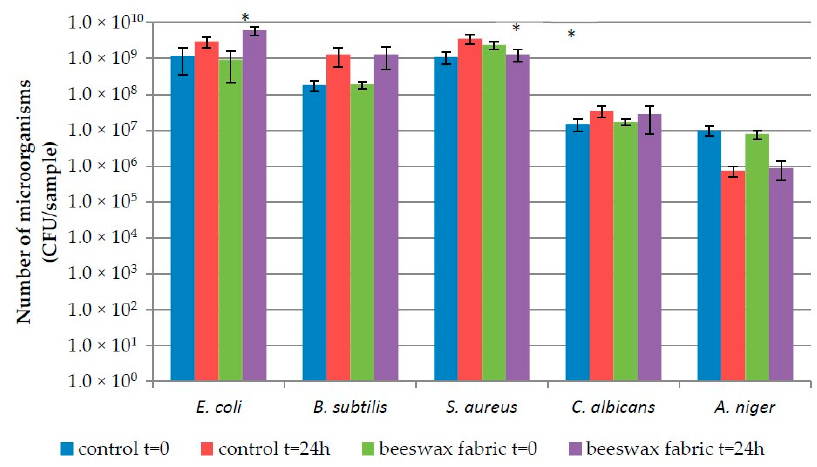
Figure 4. Number of microorganisms on Fabric 1; *—Statistically significant differences between number of microorganisms on control and beeswax-modified samples in the same time (one-way ANOVA, p < 0.05).